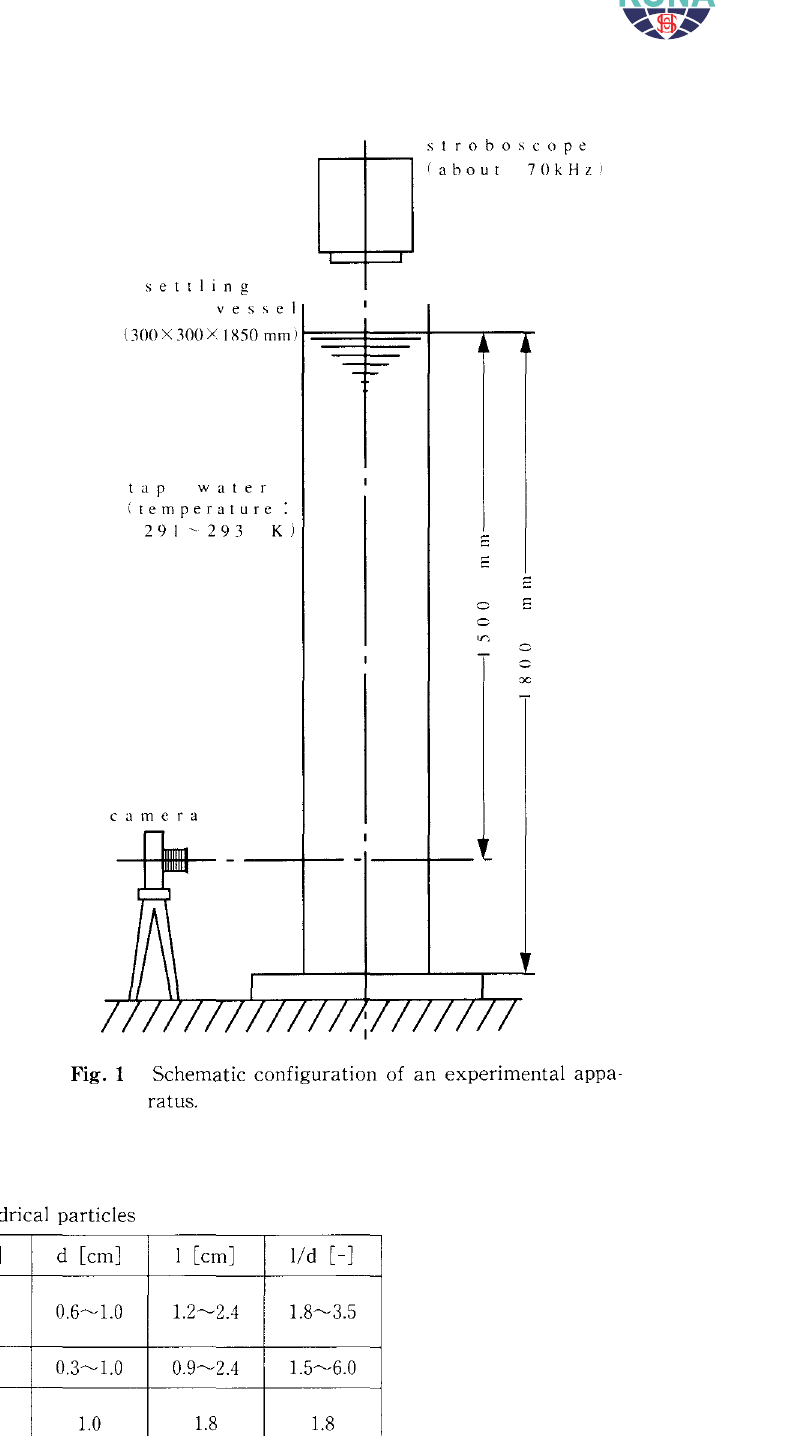
Table 1 Density and sized of cylindrical